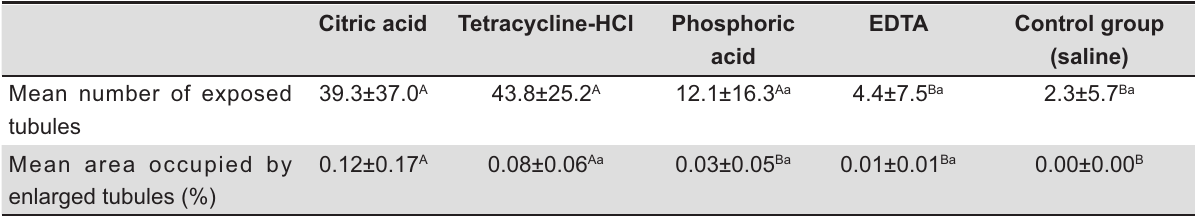
Table 1- Mean number of exposed dentin tubules and corresponding area after conditioning with the four different demineralizing